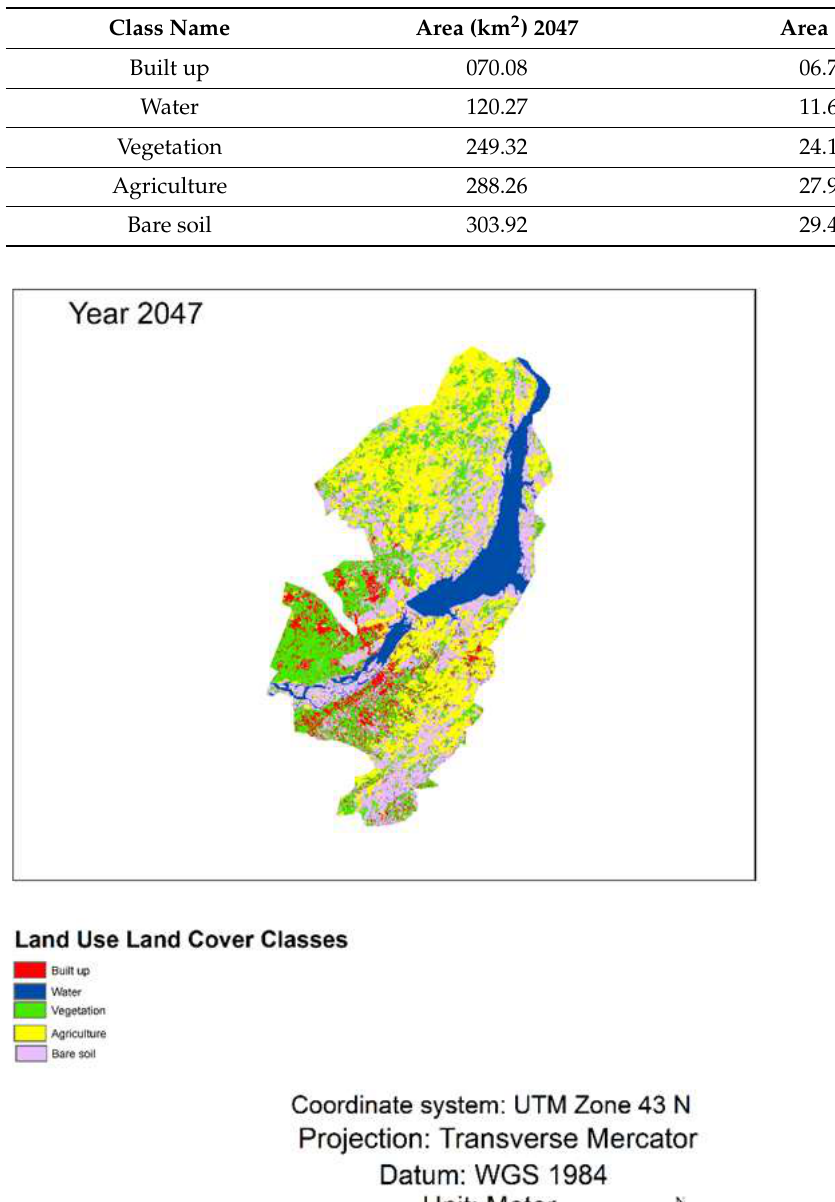
Table 4. Land use land cover condition projection for the year 2047.